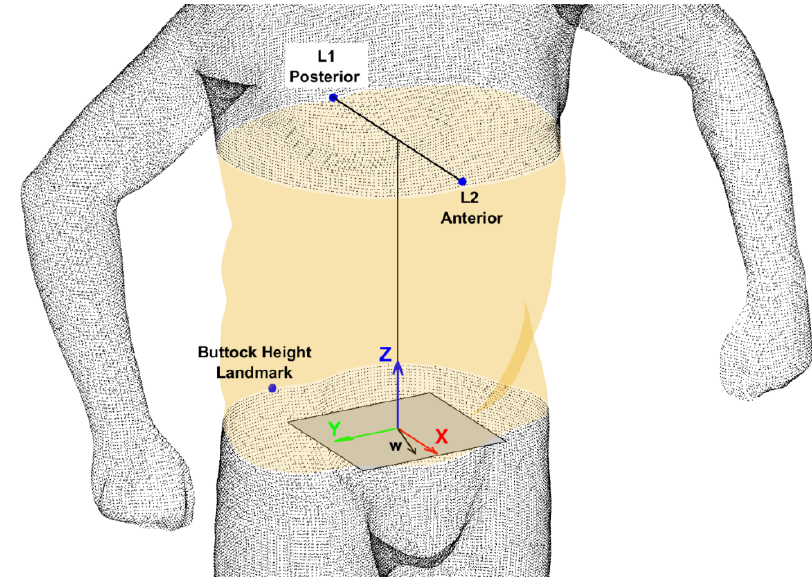
Figure 2. Landmarks used to segment the torso and create a local co-ordinate system within each 3D image, originally used in Thelwell et al. [25]. Please note, the scan data in this figure are for illustrative purposes only.